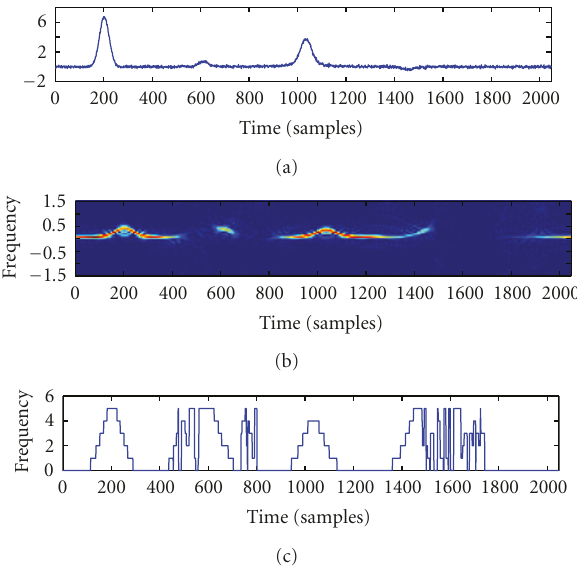
Figure 16: (a) Theoretical instantaneous frequency law (IFL) of s ; (b) IFL obtained by GCD for SNR = 30 db; (c) associated detection curve.